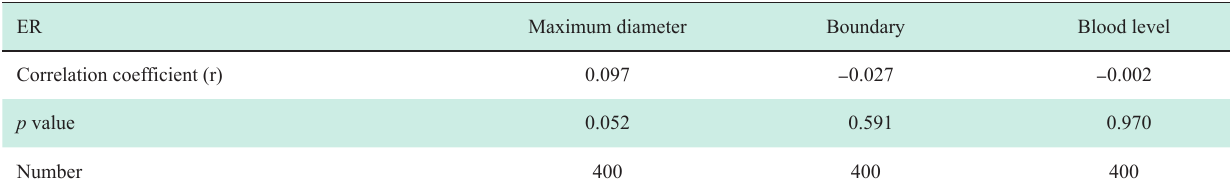
Table2 Correlation between tumor maximum diameter, tumor boundary, blood flow signal classification and PR ER